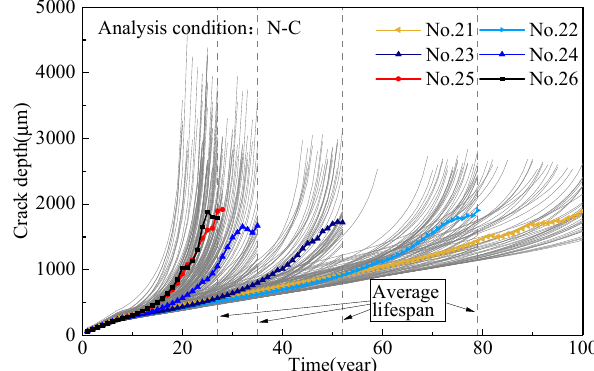
Figure 15. Development of average crack depth.